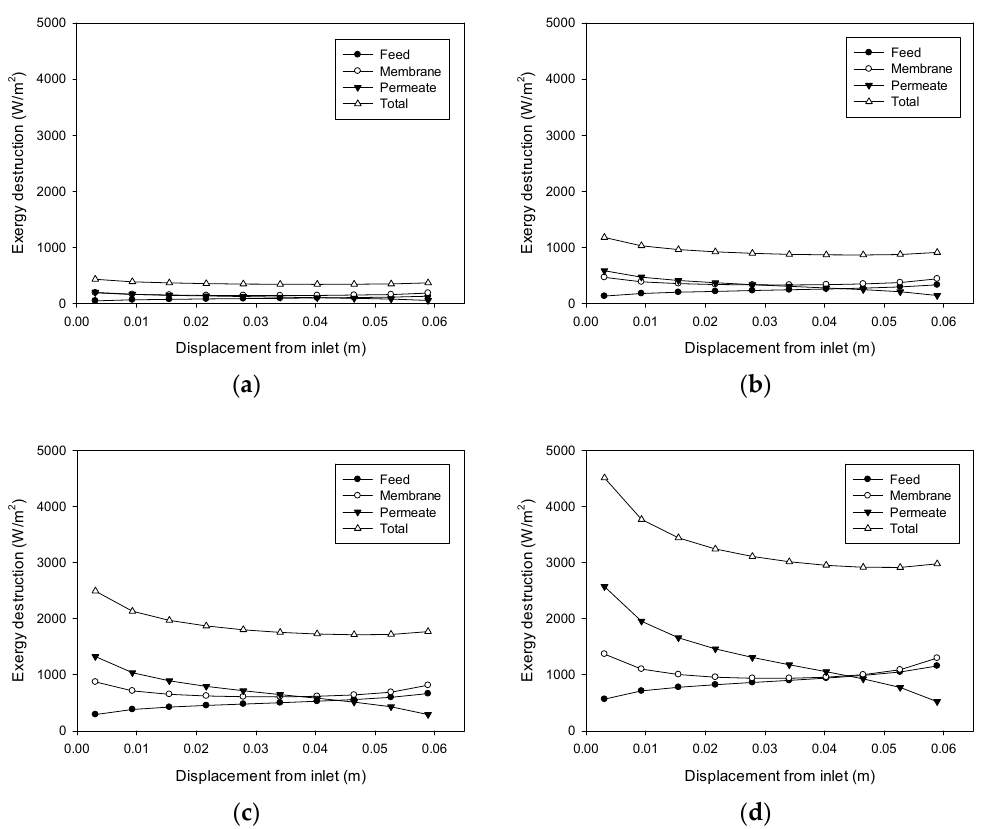
Figure 8. Profiles of exergy destruction in the DCMD module: ( a ) Feed temperature = 40 °C, feed flow rate = 0.6 L/min, and permeate flow rate = 0.4 L/min; ( b ) Feed temperature = 50 °C, feed flow rate = 0.6 L/min, and permeate flow rate = 0.4 L/min; ( c ) Feed temperature = 60 °C, feed flow rate = 0.6 L/min, and permeate flow rate = 0.4 L/min; ( d ) Feed temperature = 70 °C, feed flow rate = 0.6 L/min, and permeate flow rate = 0.4 L/min.